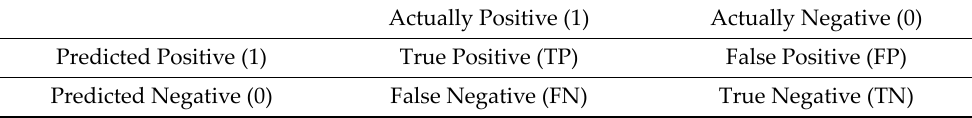
Table 6. Confusion matrix.